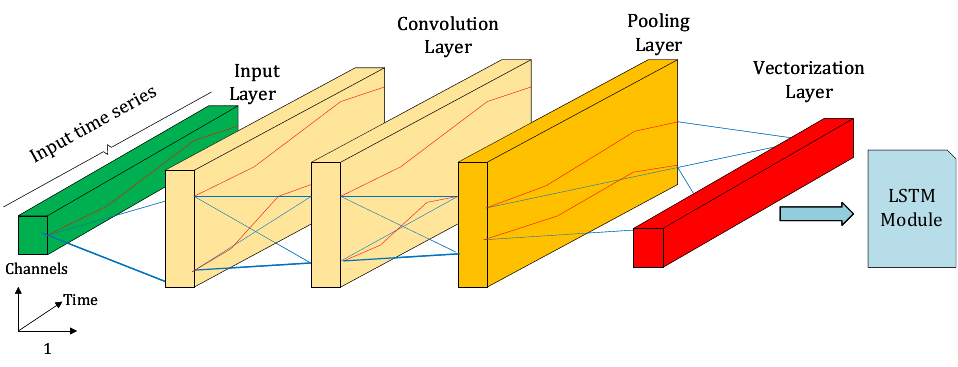
Figure 6. Temporal convolutional neural network architecture.